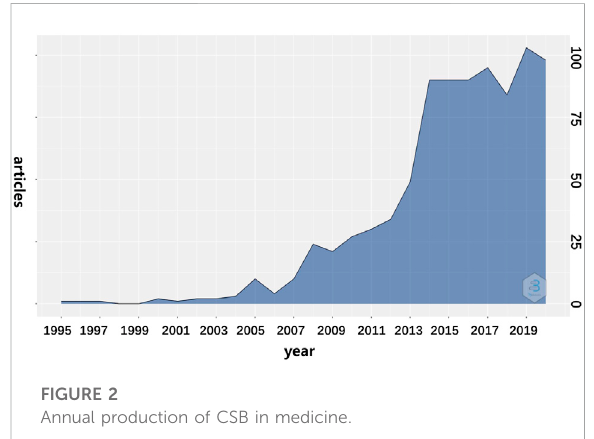
FIGURE 2 Annual production of CSB in medicine.